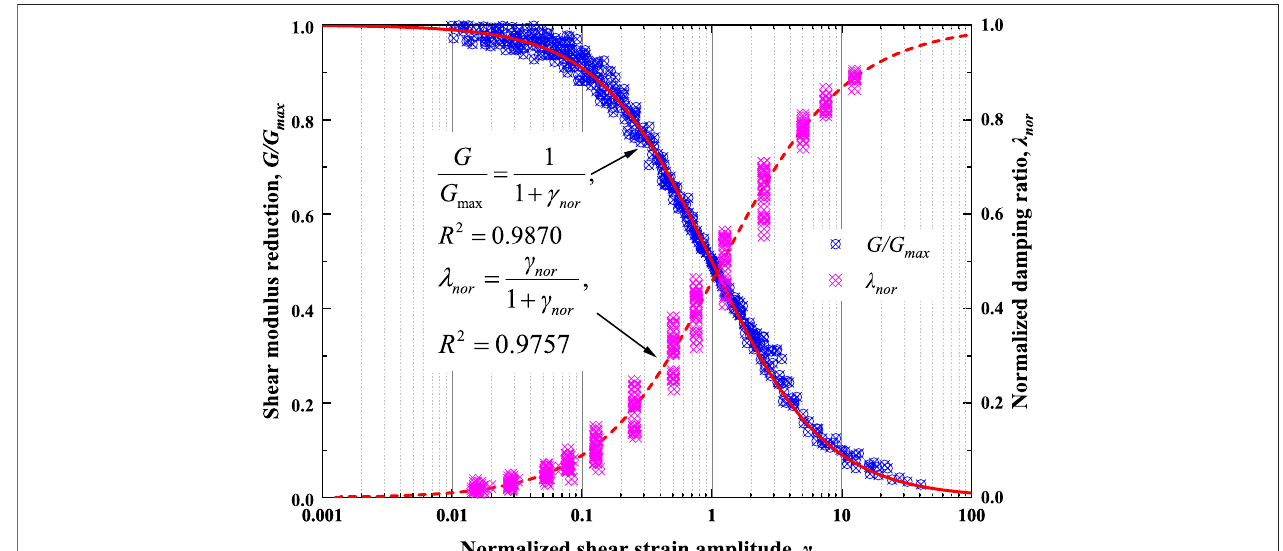
FIGURE 3 | Relationships of the G / G max and λ nor of GSCGS with c nor